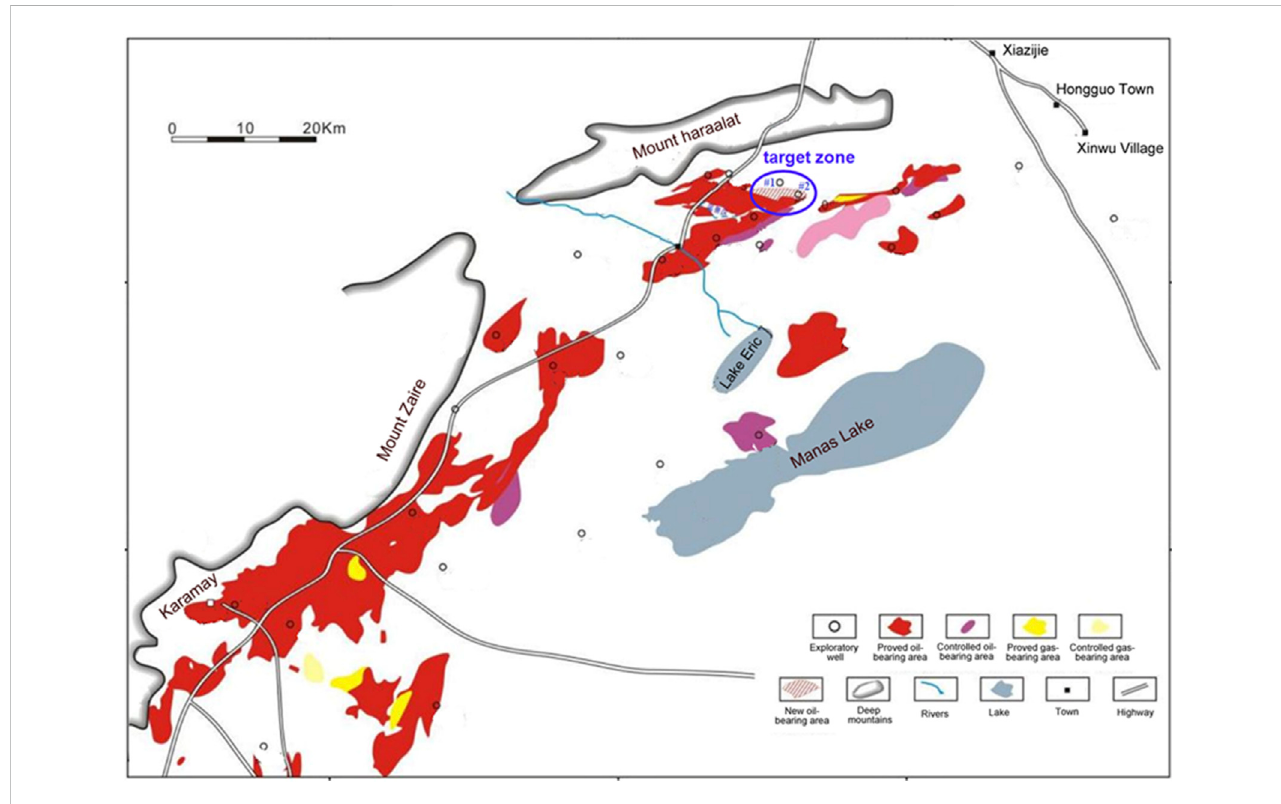
FIGURE 1 Geographical location map of Fengcheng oil fi eld (adapted from Zhou, 2016).